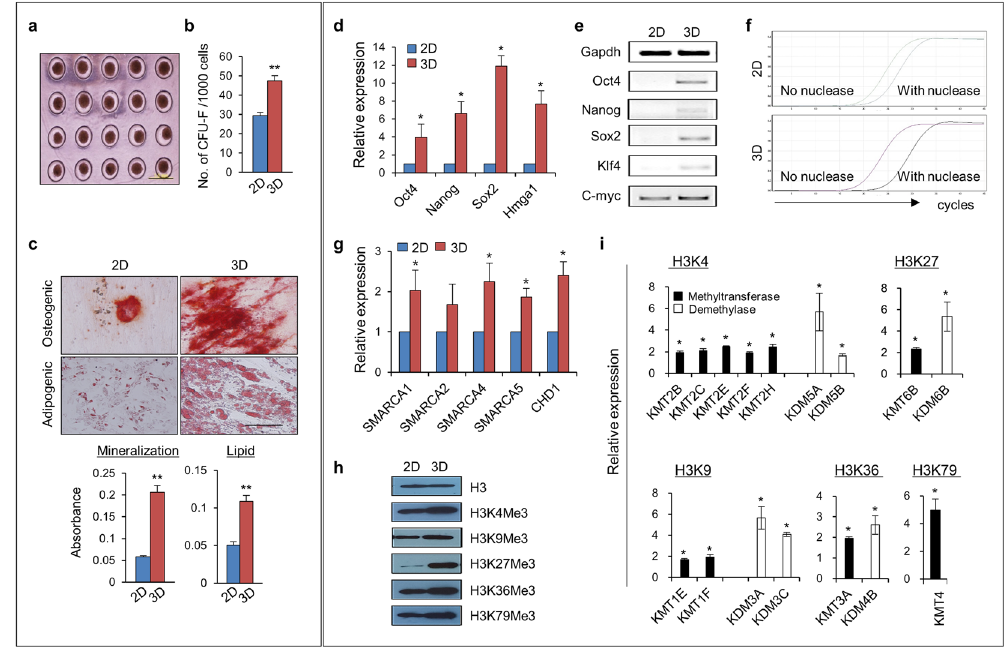
Figure 1. 3D spheroid MSCs acquired stem cell-like properties through chromatin dynamics and epigenetic plasticity. ( a ) Light microscopy of adipose-derived MSCs aggregated in PDMS microchips at 24 h after plating (scale bar, 1000 μ m). ( b ) Frequency of colony forming unit-fibroblasts (CFU-F) in 2D or 3D MSCs. Shown are the numbers of CFU-F obtained after plating 1 × 10 3 cells (mean ± SEM, from three experiments; n = 9; ** p < 0.01). ( c ) Multi-lineage differentiation of 2D and 3D MSCs. Osteogenic and adipogenic differentiation results were quantified by mineralization (Alizarin red) and lipid droplet deposition (oil red O) after 21 and 14 days of differentiation, respectively. Shown are the representative images (upper) and spectrophotometric quantification (lower) of mineralization and lipid droplet deposition (mean ± SEM, three experiments; n = 6; ** p < 0.01). ( d and e ) Expression of pluripotency-related genes in 2D or 3D MSCs. Shown are the relative fold changes in expression for the indicated genes in 3D MSCs relative to 2D MSCs, as determined by real-time RQ-PCR with normalization to GAPDH levels (mean ± SEM, three experiments; n = 6; * p < 0.05) ( d ) along with representative images of RT-PCR analysis ( e ). ( f ) Chromatin accessibility to the Oct4 gene promoter was compared for 2D MSCs (upper) and 3D MSCs (lower) by nuclease protection assays. ( g ) Fold induction of chromatin remodeling genes in 3D MSCs relative to 2D MSCs as determined by qPCR analysis with normalization to GAPDH levels (mean ± SEM, three experiments; n = 6; * p < 0.05). ( h ) Western blot analysis of histone methylation marks in total cell lysates (three experiments, n = 3). ( i ) Quantitative analysis of the expression levels of histone methyltransferases and demethylases for each of the indicated histone marks. Shown are the mean fold changes in 3D MSCs relative to 2D MSCs, as determined by qPCR with normalization to GAPDH levels (mean ± SEM, three experiments; n = 6; * p <